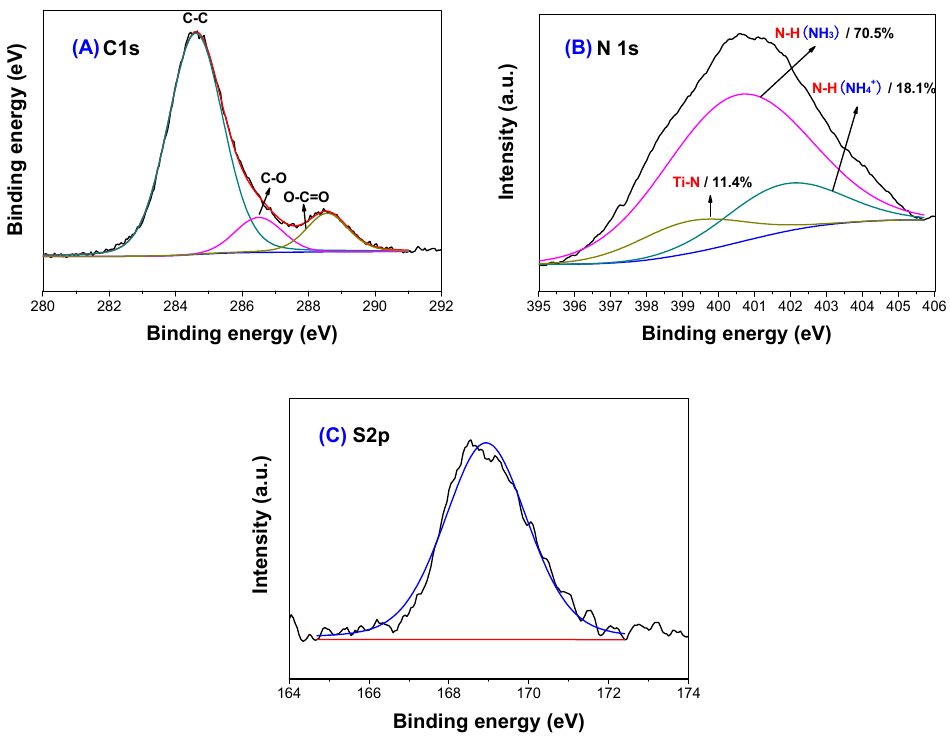
Figure 6. High-resolution XPS spectra of the C 1s ( A ); N 1s ( B ) and S 2p ( C ) regions of R2 sample. Table 2. XPS characterization results of the photocatalysts.